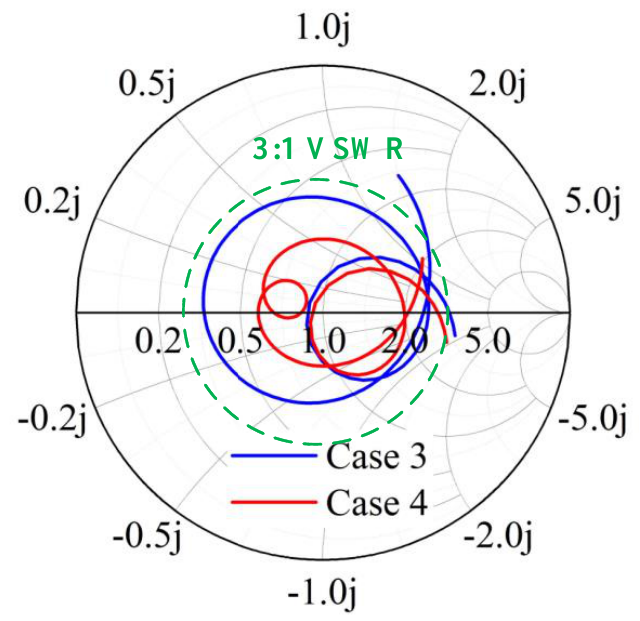
Figure 8. Comparisons of Case 3 and Case 4. Smith charts from 3.2–5.3 GHz.